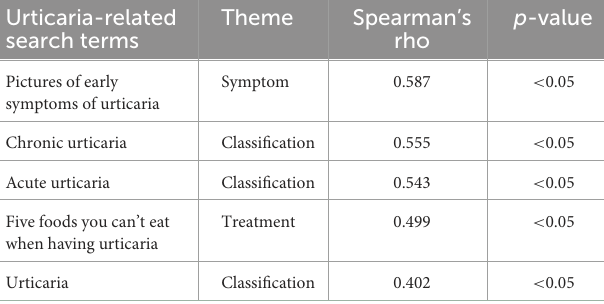
TABLE 3 The top-5 strongest correlation between daily BSIs of urticaria-related search terms and the daily doses of COVID-19 vaccination between March 24, 2021 and April 23,